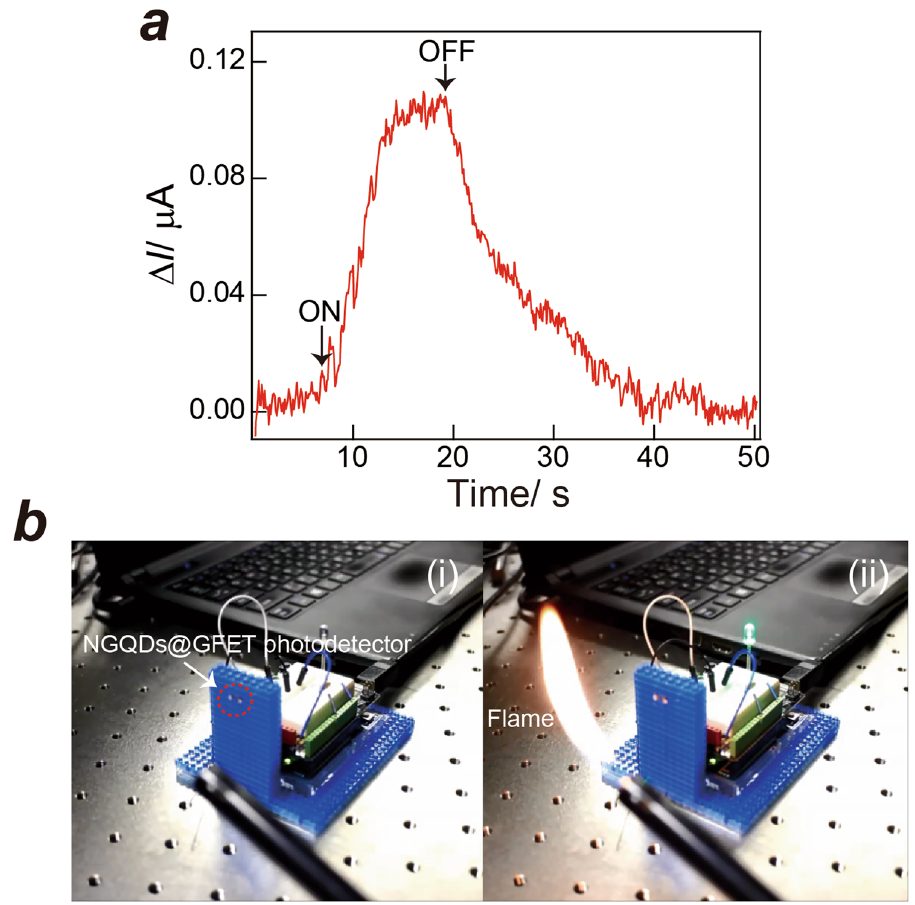
Figure 4. ( a ) Change in the photocurrent under UV light irradiated from a flame (the distance between the photodetector and flame was ca. 1 m. ( b ) Digital images (snapshots from Movie S1, Supplementary Information) showing the operation of the flame alarm using a NMe 2 -GQD@GFET hybrid photodetector. (i) Schematic of the prototype flame alarm. (ii) The green-LED of the fire alarm was turned on when the flame was